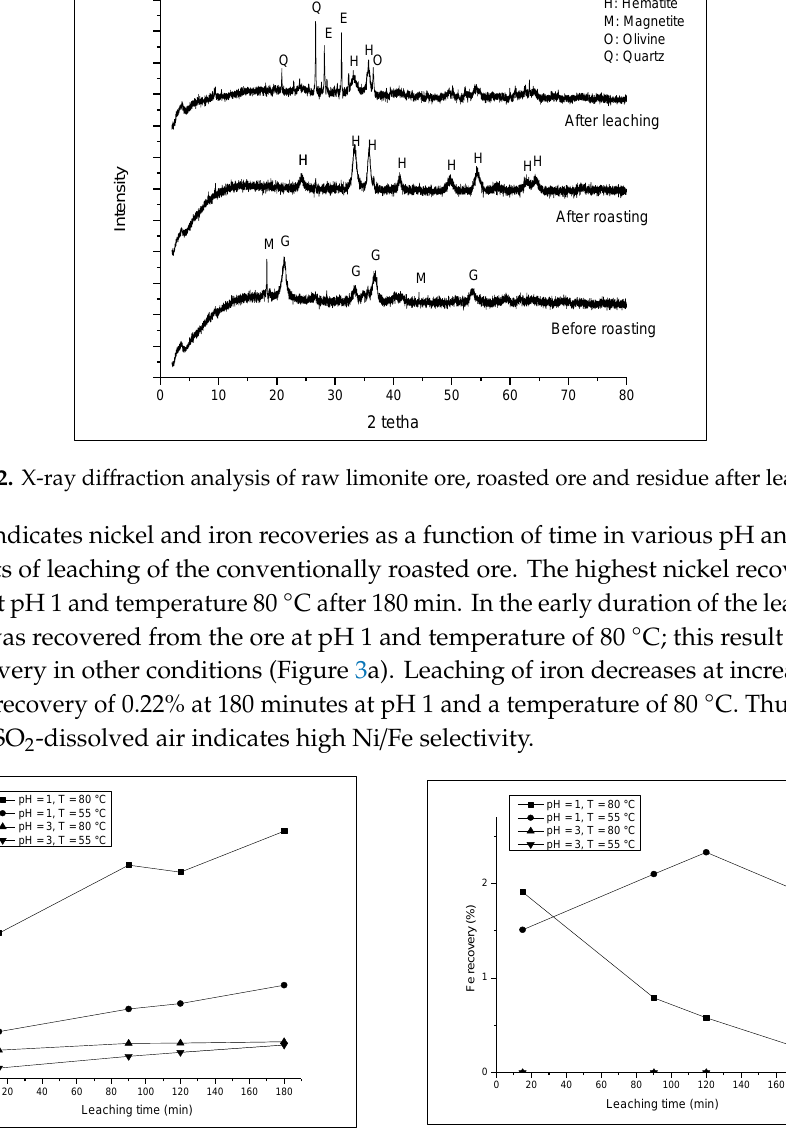
Figure 3. Recovery of nickel and iron using conventional roasting pretreatment and leaching using SO 2 -dissolved air. ( a ) nickel recovery; ( b ) iron recovery.